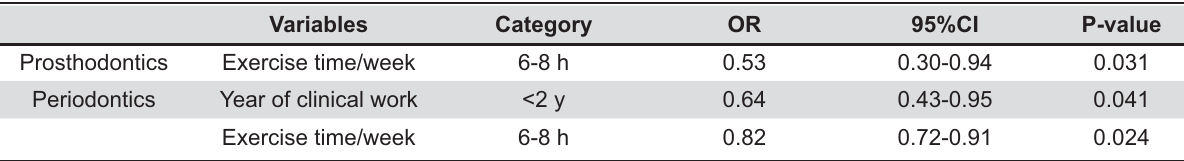
Table 4- Protective factors of Musculoskeletal disorders